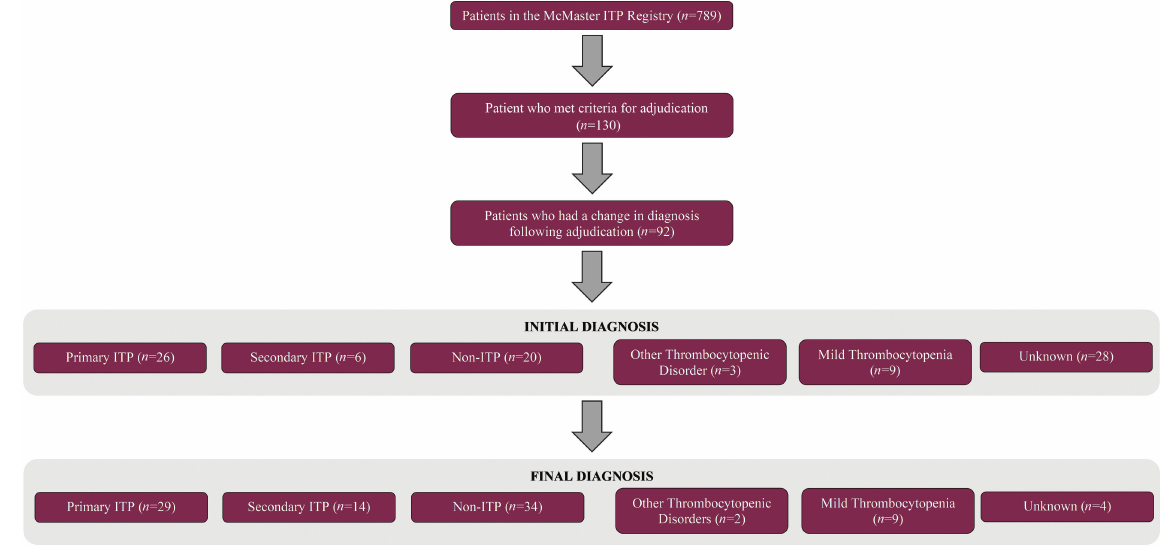
Fig. 2 Flowchart showing the number of patients whose diagnosis changed after adjudication.